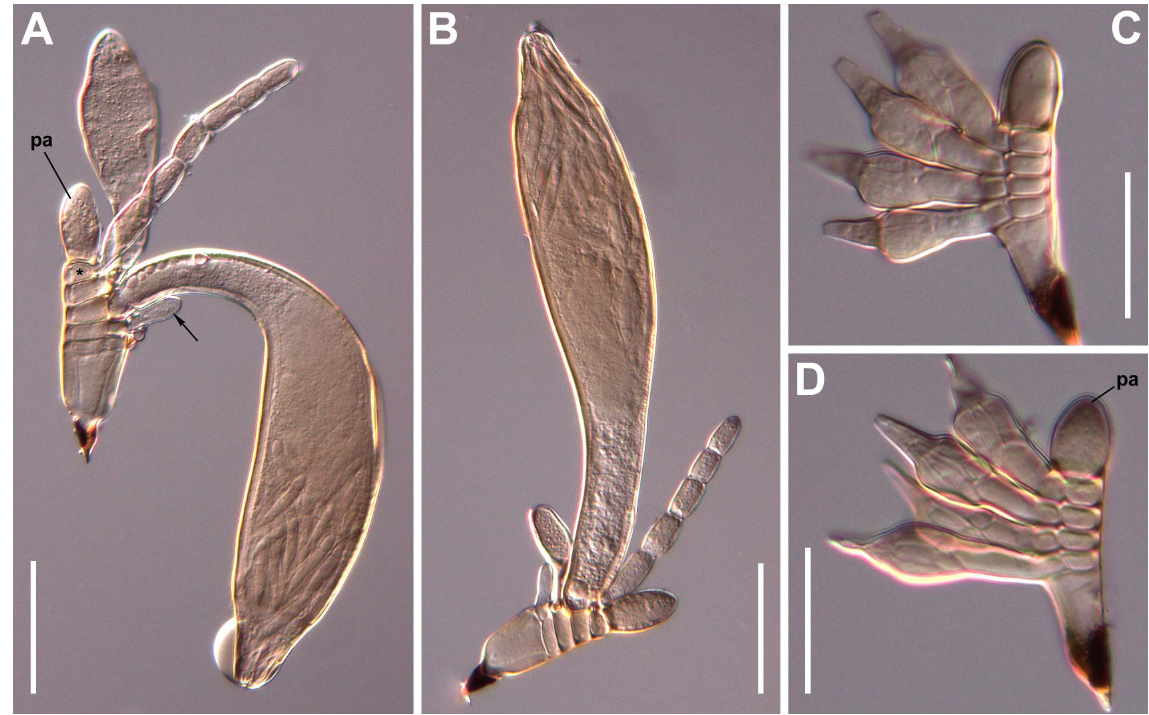
Fig. 71. Dimeromyces corynetis Thaxt. A – B . Female mature thalli with labelled primary appendage (pa), a unicellular secondary appendage (arrow), and the uppermost receptacular cell (*) in A. C – D . Male thalli showing primary appendage (pa). Scale bars: A–B = 50 µm; C–D = 25 µm. Photographs from slide ZMUC